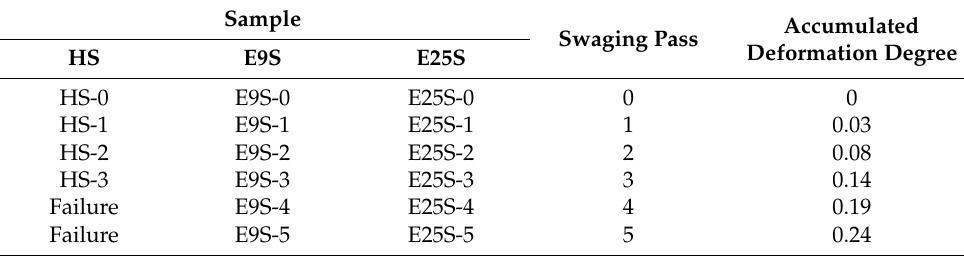
Table 2. The same accumulated deformation degree of homogenized sample (HS) and extruded samples with extrusion ratios of 9 (E9S) and 25 (E25S), respectively. Sample Swaging